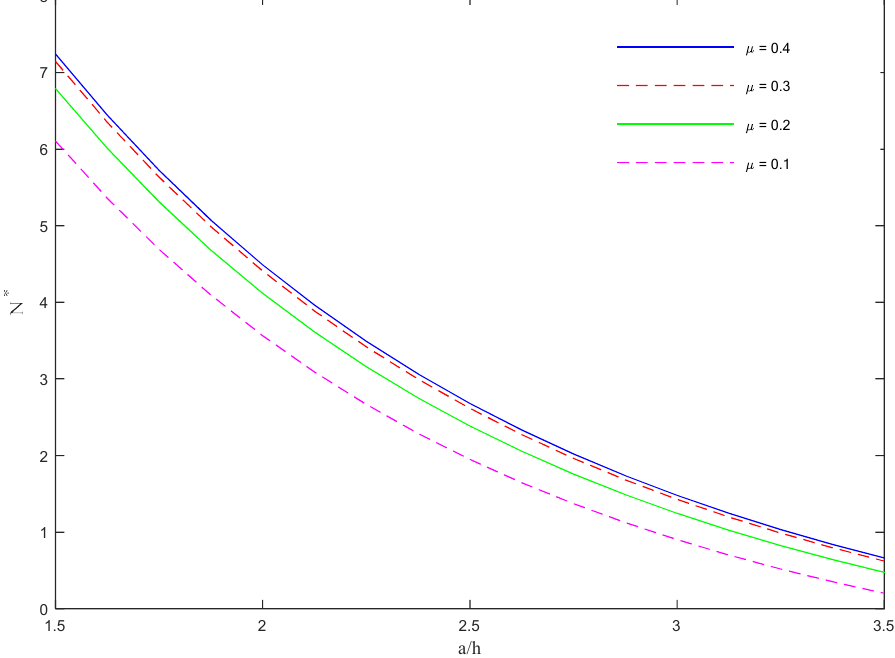
Figure 5. Dimensionless critical buckling load versus rational a / h for different values of μ .